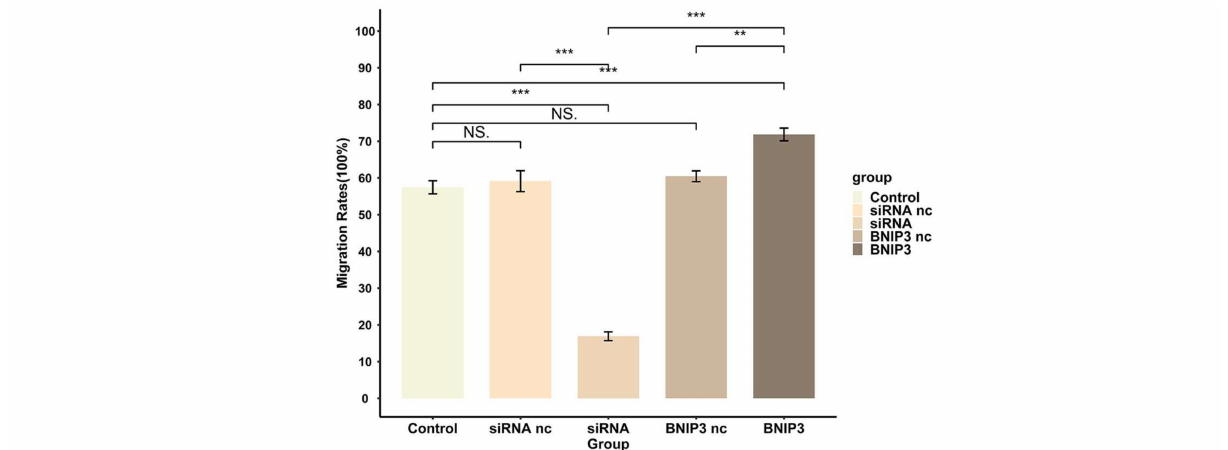
Figure 18. BNIP3 regulates the migration ability of osteosarcoma cells; knockdown of BNIP3 inhibits their migration ability, while overexpression of BNIP3 promotes the migration ability of osteosarcoma cells. “NS” represented “No significant difference”, “**” represented “ p < 0.01”, “***” represented “ p <